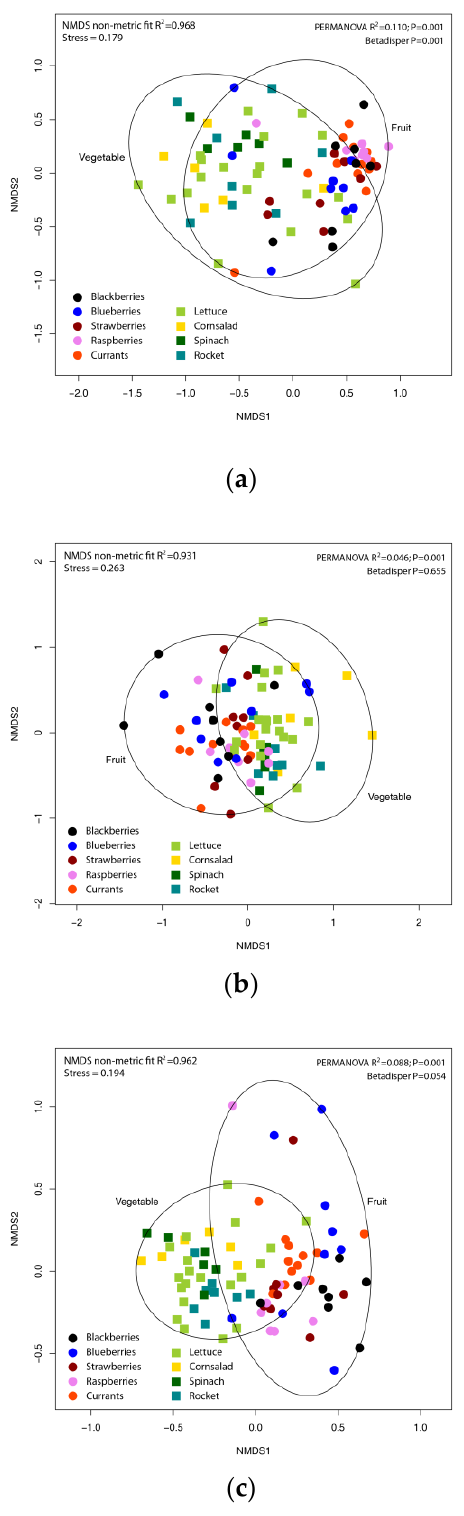
Figure 5. NMDS scatterplots of microbial communities in samples of leafy vegetables and berry fruits. ( a ) Bacterial community in fresh tissue samples; ( b ) fungal community in fresh tissue samples; ( c ) Bacterial community in sample pre incubated in buffered peptone water.